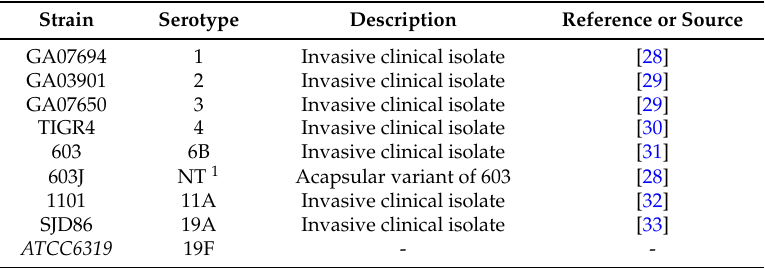
Table 1. Streptococcus pneumoniae strains used in this study.